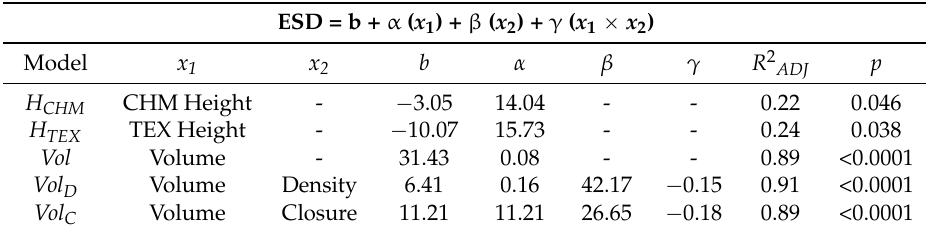
Table 2. Predictive model structures tested in the study. Models driven by height or volume alone contain only a slope ( α ) and intercept ( b ) as parameters, whereas models with two inputs ( Vol D and Vol C ) contain an additional primary and interaction term ( β and γ ). ESD, equivalent stem